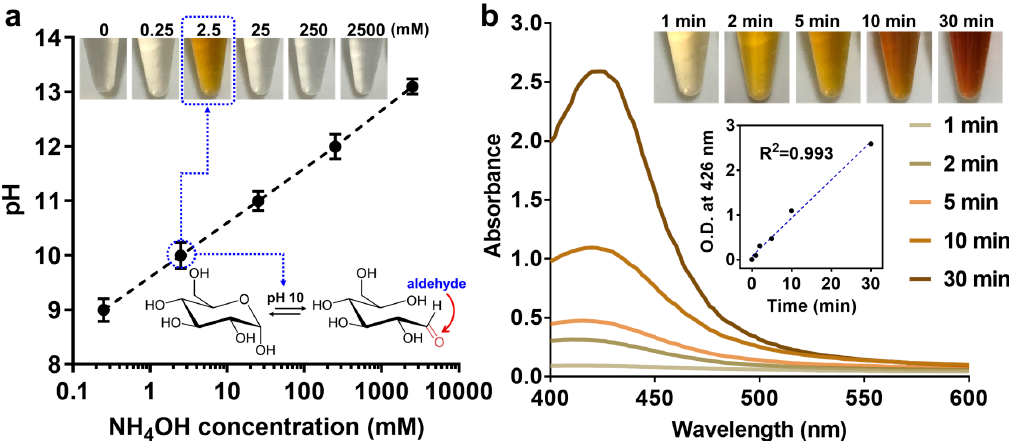
Figure 1. (a ) pH of the reaction solution versus concentration of NH 4 OH. The upper inset shows the photographic image of reaction tubes containing AgNPs formed with debranched starch in the presence of varying concentrations of NH 4 OH under UV irradiation for 5 min. The inset within the plot shows the transition of glucose from a cyclic form to the open-chain aldehyde form at pH 10. ( b ) UV-vis absorption spectra of the reaction at a given time point for 30 min in the presence of debranched starch and 2.5 mM of ammonium hydroxide under UV irradiation. The debranched starch was obtained by debranching native waxy maize starch (0.1 mg/mL) using 1 ASPU/mL of pullulanase (ASPU is defined as the amount of enzyme that liberates 1.0 mg glucose from starch in 1 min at pH 4.4 and 60 °C). The upper inset shows the photographic image of the reaction tubes at each time point of the reaction. The lower inset shows the plot of the surface plasmon resonance (SPR) absorption intensity of AgNPs at 426 nm versus reaction time under UV irradiation. O. D. = optical density. R 2 = correlation coe ffi